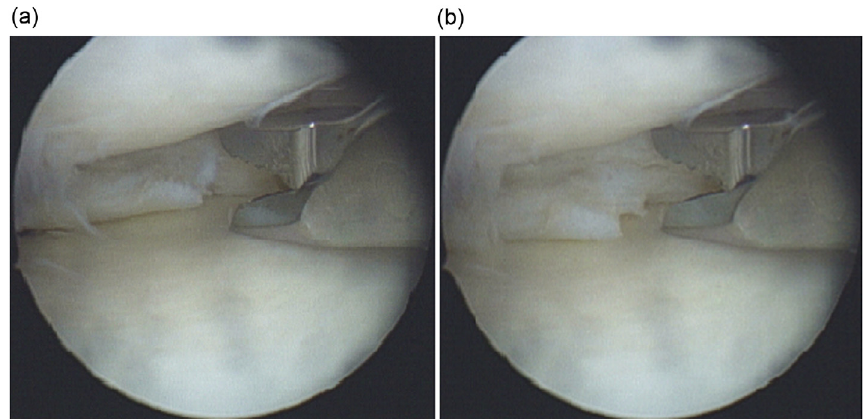
Figure 3. (a, b) Arthroscopic image of left knee showing approach of basket punch to the posterior horn of medial meniscus with and without the maneuver.